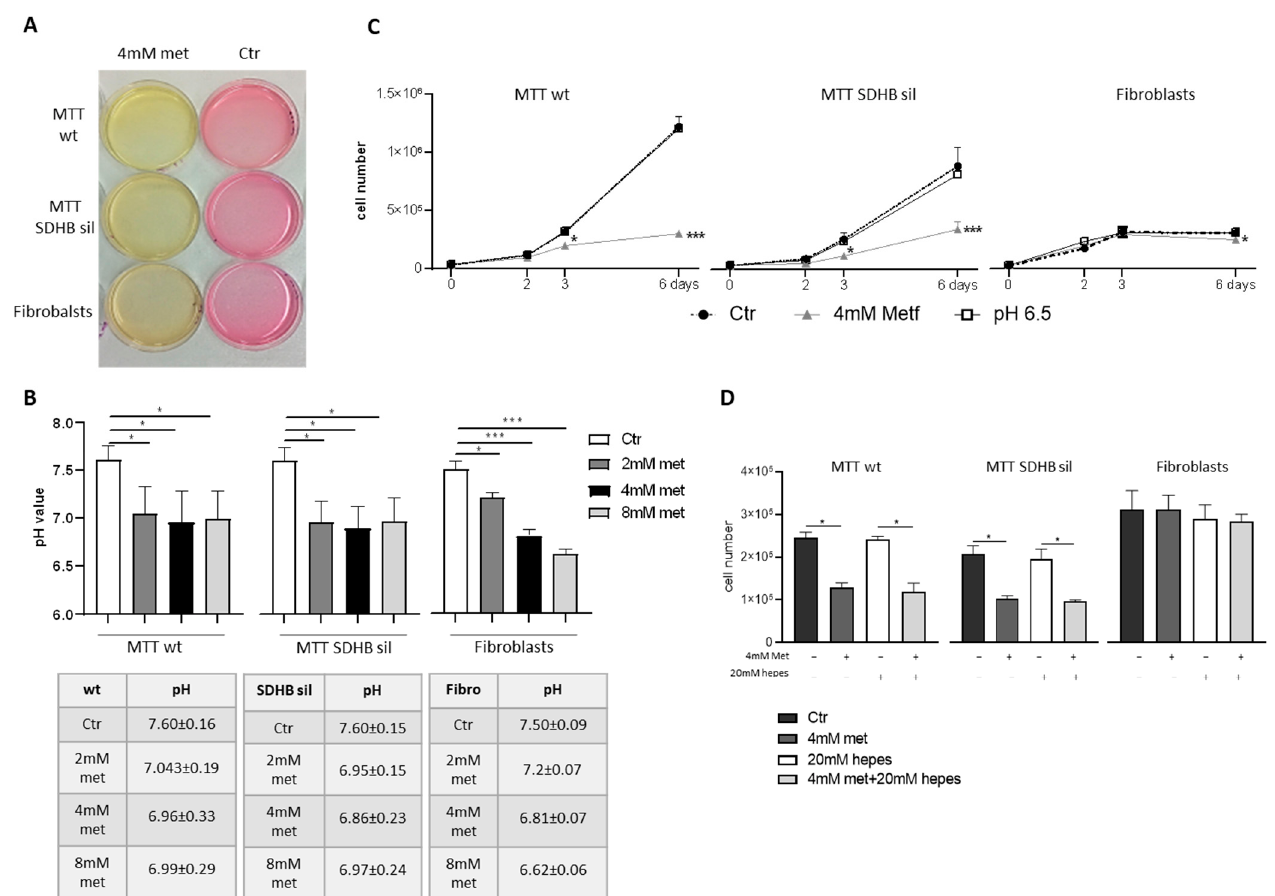
Figure 3. Effect of metformin in culture medium acidification. ( A ) Culture media turned into a yellow colour after 72 h of metformin administration. ( B ) pH measurement showed a significant acidification of the media of MTT (both wt and SDHB sil), and fibroblasts after 2 mM (dark grey bars), 4 mM (black bars) and 8 mM (light grey bars) metformin treatment, compared with not treaded controls (white bars). Bars are the media of three independent experiment ± SD. Asterisks indicate significance (* p < 0.05, *** p < 0.001) by one-way ANOVA with Dunnet post hoc test. Tables indicate the pH value ± SD. ( C ) Proliferation of MTT wt, MTT SDHB sil, and fibroblasts grown in acidic medium (pH 6.5) or in 4 mM metformin medium compared with controls (cells grown in DMEM + 10% FCS, pH 7.4). Graphs represent three independent experiments performed in duplicates, and asterisks indicate significance (* p < 0.05) by two-way ANOVA with Bonferroni post hoc test ± SD. ( D ) Cell proliferation of control cells (black bars), after 72 h of 4 mM metformin administration (dark grey bars), DMEM plus 20 mM of hepes (white bars), and following 20 mM of hepes plus 4 mM metformin 72 h (light grey bars). Graphs showed a significative reduction of only MTT growth after metformin treatment regardless of the presence of hepes in the medium, confirming that the effect of metformin was not acidic-dependent. Bars represent two independent experiments performed in triplicates, and asterisks indicate significance (* p < 0.05, *** p < 0.001) by one-way ANOVA with Tukey post hoc test ± SD.